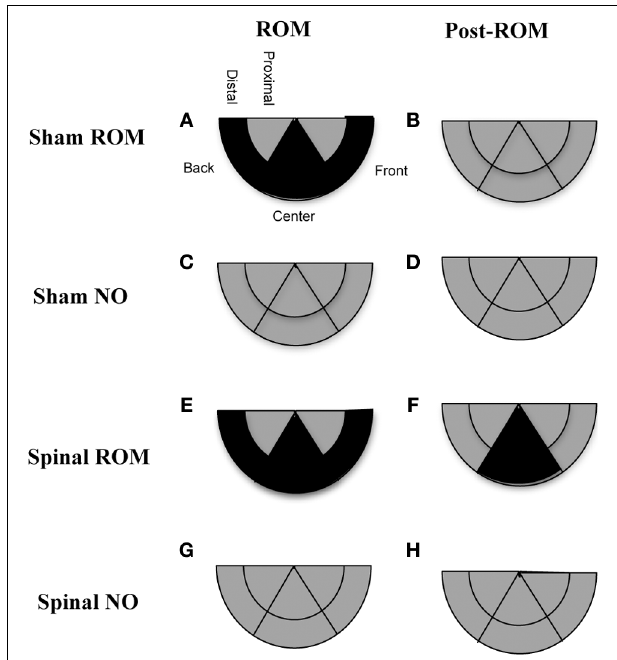
FIGURE 10 | Summary of changes in hindlimb trajectories for sham and spinal P10 rats by ROM restriction condition. Changes in limb trajectories are show for sham subjects that experienced ROM restriction (A,B) , shams that did not receive ROM restriction (C,D) , spinal subjects that received ROM restriction (E,F) , and spinal subjects that did not receive ROM restriction (G,H) . The shaded regions reflect a maintenance (gray) or decrease (black) from baseline within that trajectory area during the designated time